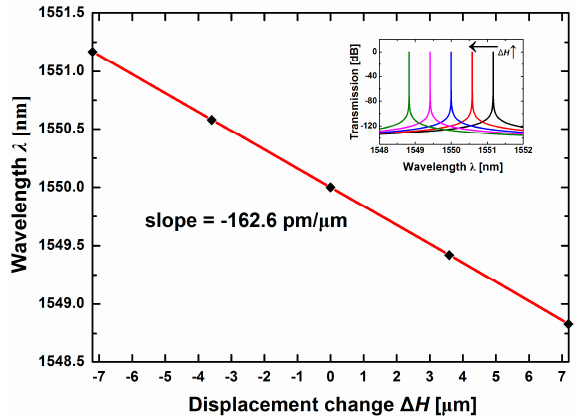
Figure 3. Shift of the transmission peak wavelength with respect to the displacement Δ H caused by the acceleration. The inset exemplifies the transmission peaks and their shift with the increase of Δ H